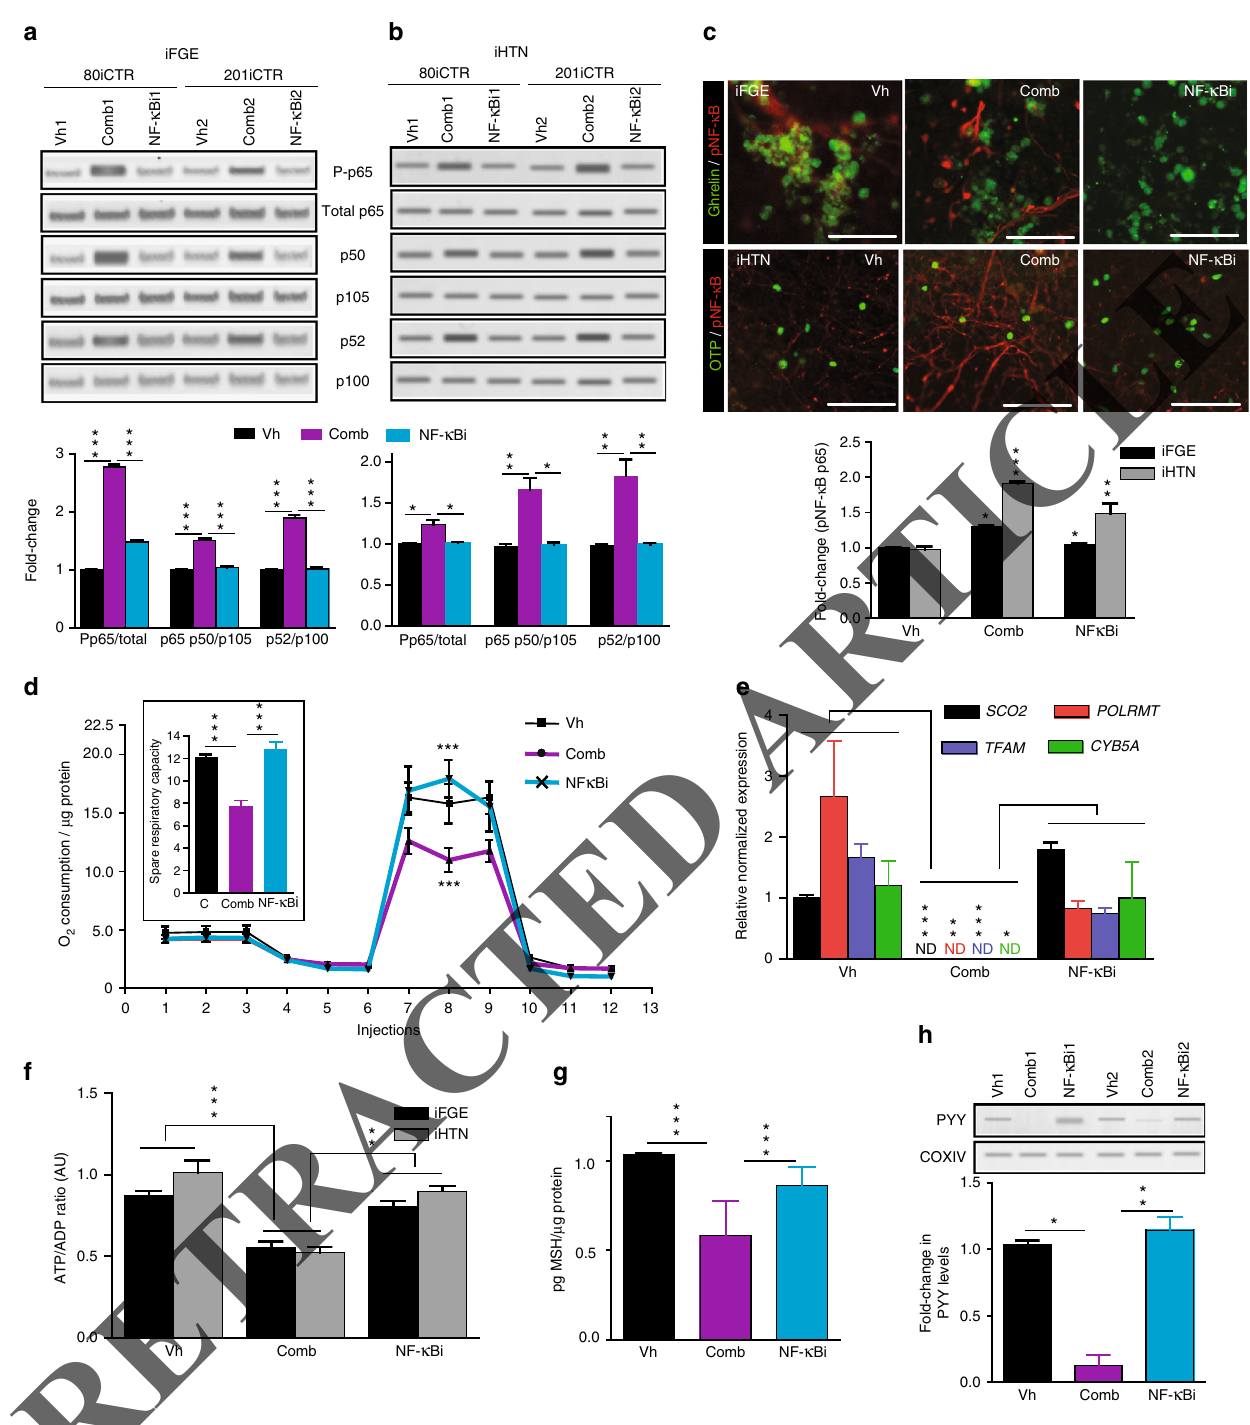
Fig. 6 Blocking NF-kB pathway rescues EDC-mediated metabolic stress and endocrine dysfunction. NF-kBi treatment decreases EDC-mediated increases in phosphorylated p65, p50, and p52 in a iFGEs and b iHTNs, * p < 0.05, ** p < 0.01, *** p < 0.001. Two different cell lines were loaded in 6 lanes with lanes 1, 2, and 3 belonging to 80iCTR (Vh1, Comb1, and NF- κ Bi1) and lanes 4, 5, and 6 from 201iCTR (Vh2, Comb2, and NF- κ Bi2). c Immunocytochemistry showing phosphorylated p65 staining in vehicle treatment ( Vh ), increased phospho-p65 with EDC combination treatment (Comb) that decreases with NF- κ Bi, * p < 0.05, ** p < 0.01, *** p < 0.001. d Seahorse assay showing improved mitochondrial respiration upon NF- κ Bi treatment compared with combination treatment in iHTNs, *** p < 0.001. e RT-qPCR expression levels of SCO2 , POLRMT , TFAM , and CYB5A showing decreased mitochondrial respiratory genes with combination treatment that are rescued by NF- κ Bi treatment, * p < 0.05, ** p < 0.01, *** p < 0.001. f Restoration of ATP levels upon NF- κ Bi treatment, ** p < 0.01, *** p < 0.001. g α -MSH secretion levels showed improvement upon NF- κ Bi treatment, *** p < 0.001. h Western blot showing rescue of PYY levels in iFGEs, * p < 0.05, ** p < 0.01. All statistical analysis performed using one-way ANOVA. Images and data shown are representative of average results from the two iPSC lines differentiated n = 3 times in independent experiments. Scale bars represent 50 µ m. Error bars denote